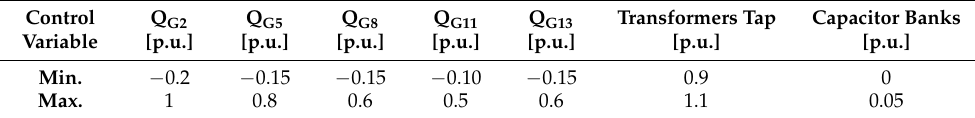
Table 8. Control variables limits for IEEE 30-bus system.